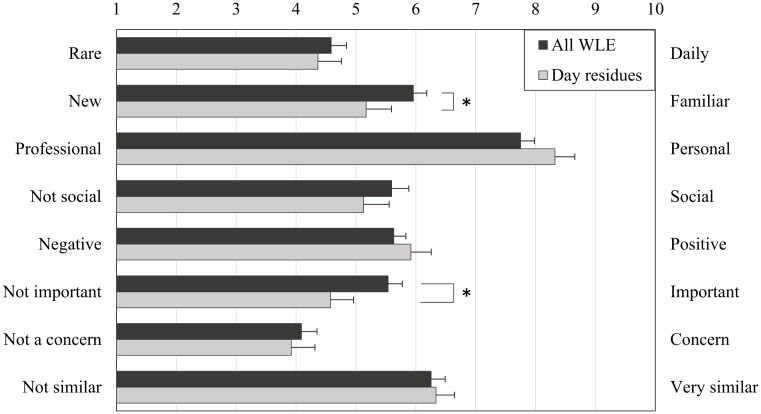
Characteristics of waking life elements incorporated into dreams.All waking life elements (black) and day residues only (grey). Error bars represent standard error of the mean. *p<.05.